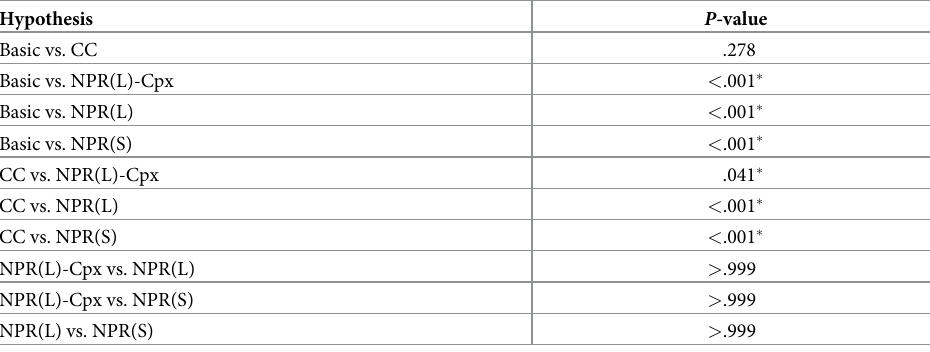
Table 9. Pairwise comparison with a Wilcoxon signed-ranks